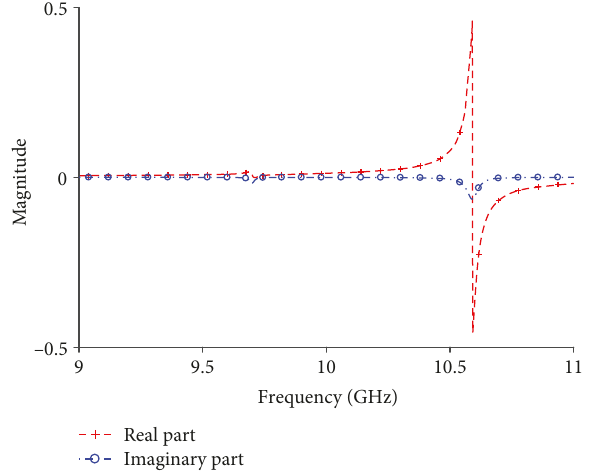
Figure 8: Frequency dependence of the e ff ective Pasteur parameter, obtained from the data shown in Figure 7. Real and imaginary